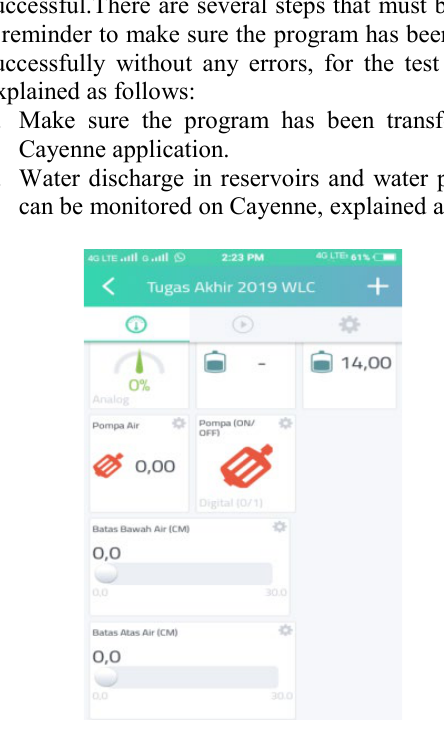
Figure 17. Discharge Display and Water Percentage From Figure 17.it is explained that there are animated